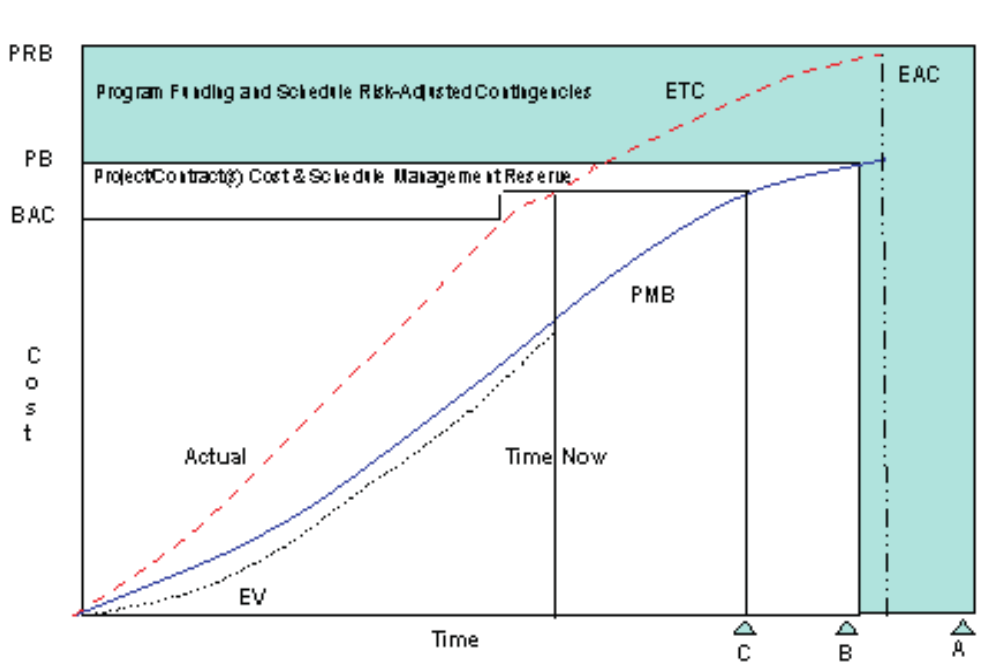
Fig. 14. Performance Measurement Baseline replan & reprogram (NDIAIPMD,